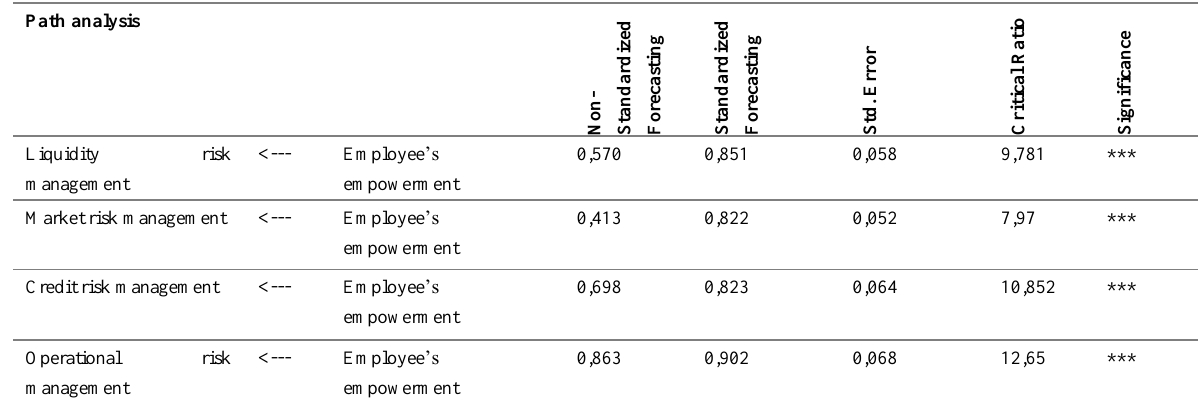
Table 8: Structural equation model regression